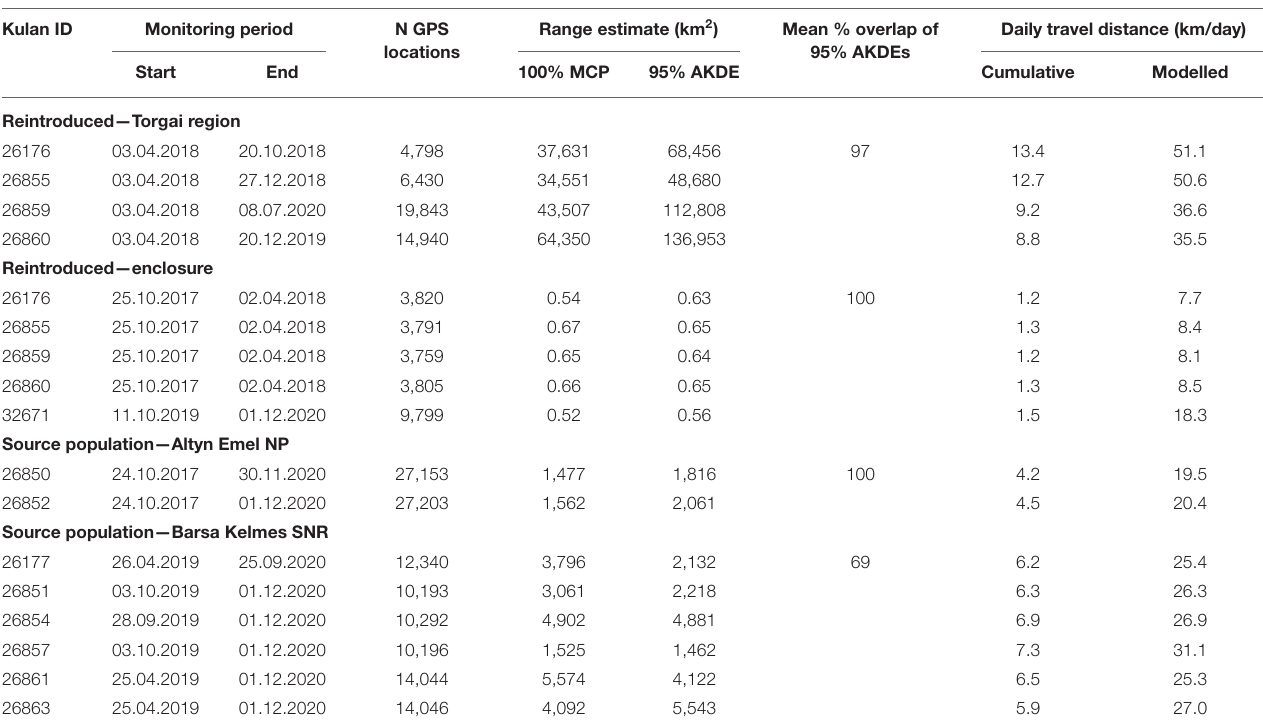
TABLE 1 | Movement characteristics of kulan reintroduced to the Torgai region as compared to those in the source populations in Altyn Emel NP and Barsa Kelmes SNR (for full model results and CI see Supplementary Table 2